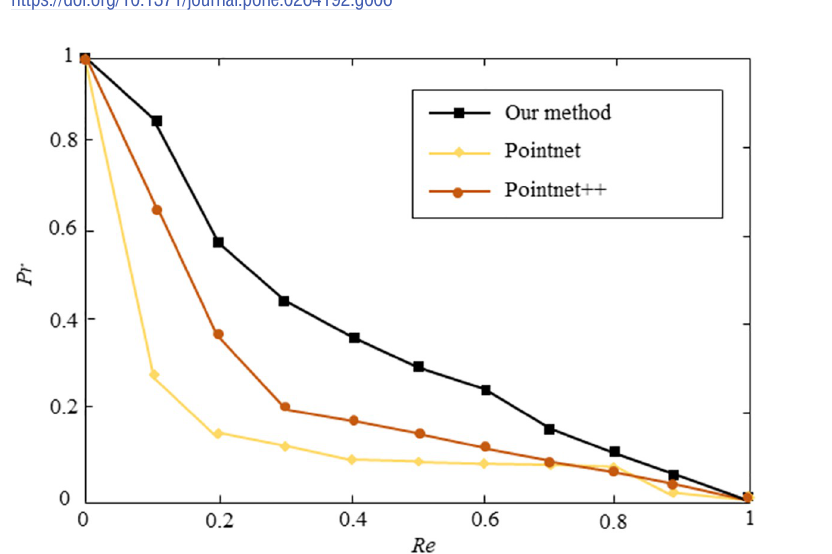
Fig 7. Performance of our method, PointNet, and PointNet++ when the training dataset contains 30 3D models. The horizontal axis represents recall rate, and the vertical axis represents precision rate. Higher curves represent better